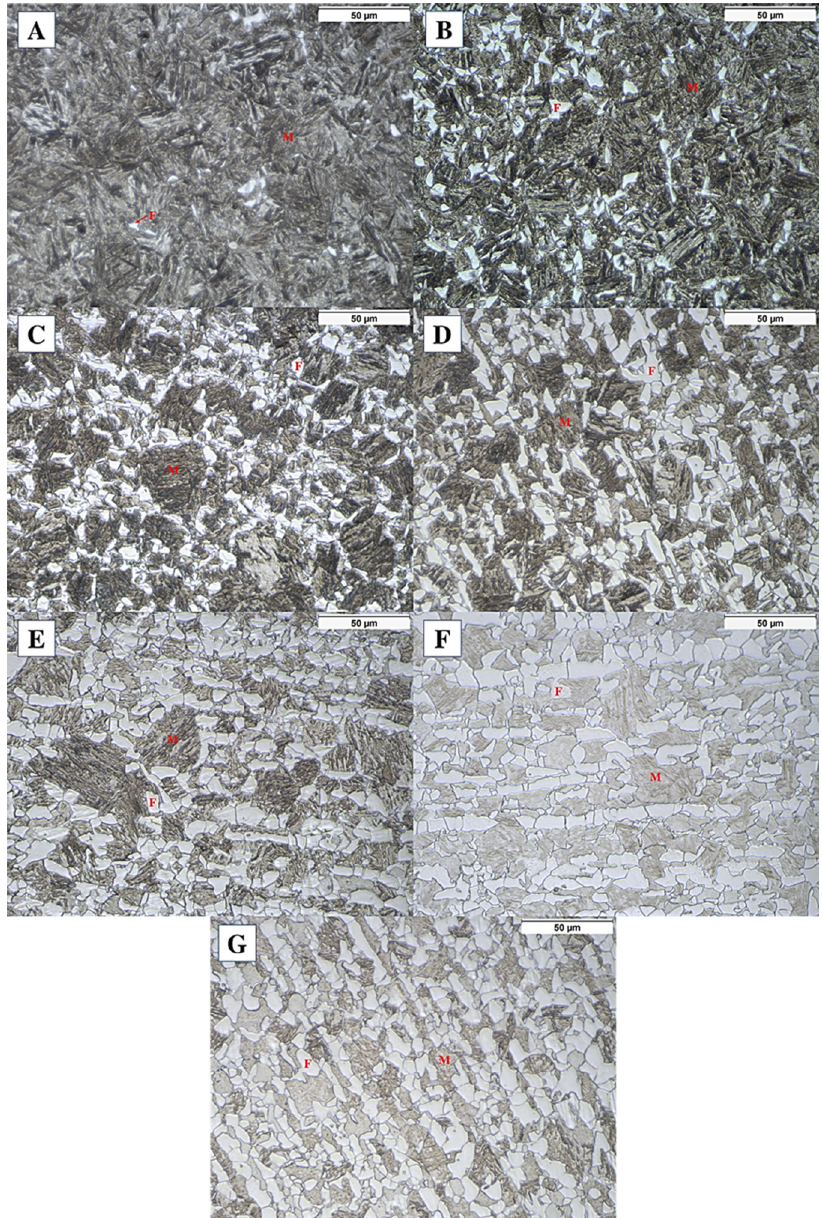
Figure 4. TRIP780 steel microstructures specimens submitted to SQ with a step temperature of 700°C. step times: A) 5s; B) 10s; C) 15s; D) 30s; E) 60s; F) 600s; G) 1200s: F: ferrite; M: martensite - OM-500x - 4% Nital